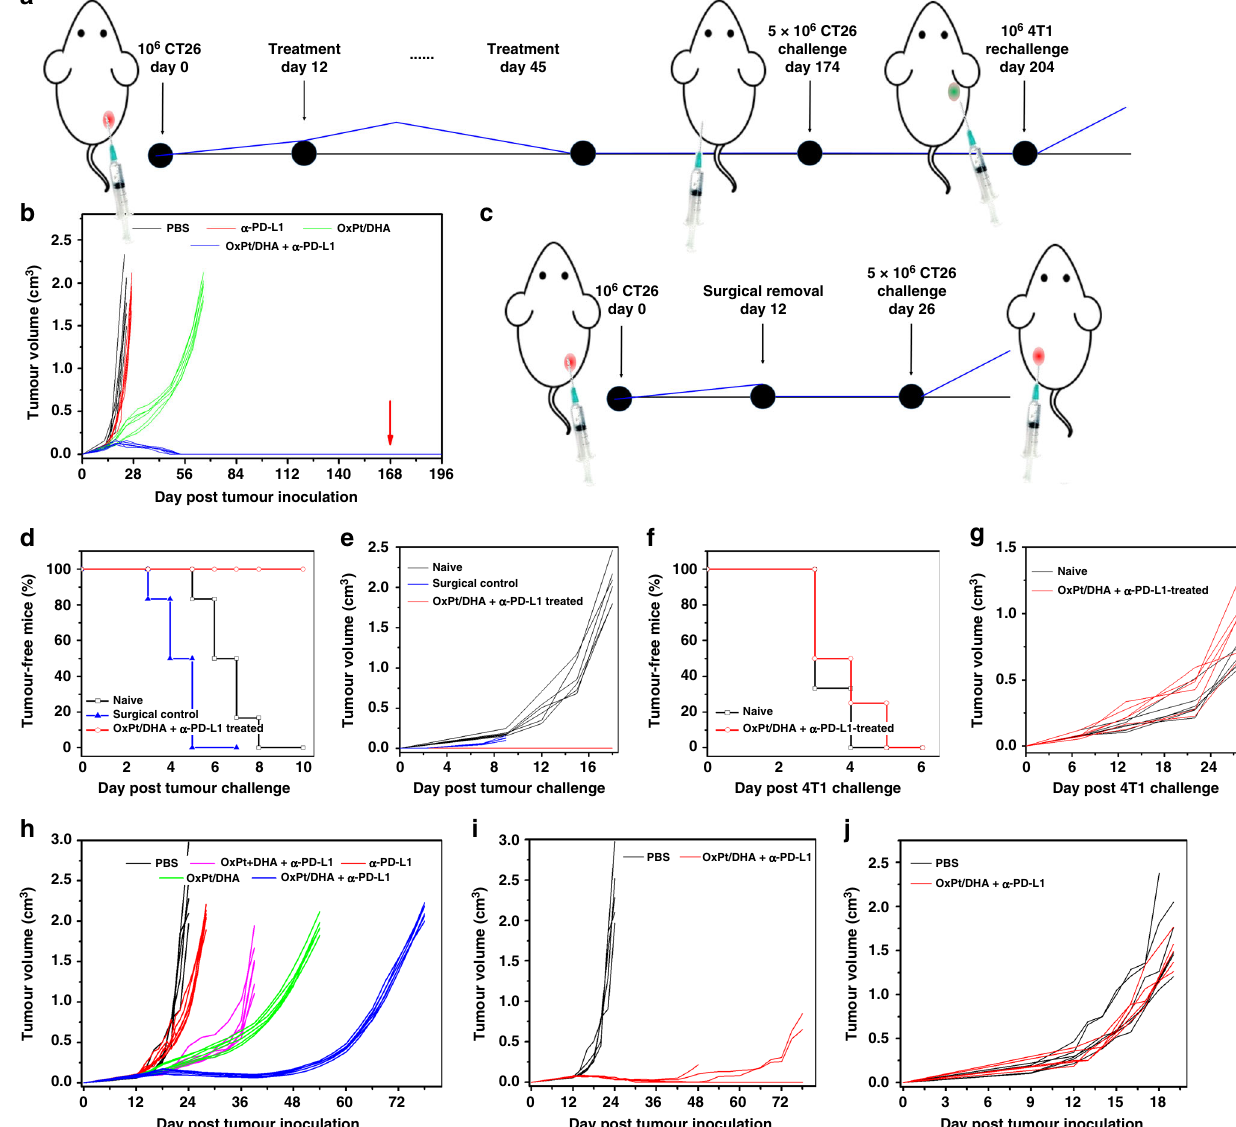
Fig. 6 Enhanced anti-PD-L1 immunotherapy on colorectal cancers. a Experimental design for the treatment and challenge of CT26 tumour-bearing mice. Tumours were allowed to grow for 12 days before treatment to form more immunosuppressive tumours. Then, tumour-bearing mice were intraperitoneally injected with OxPt/DHA combined with α -PD-L1 every 3 days for 12 total doses. Three months after all tumours had disappeared, mice were challenged with CT26 cells, followed by rechallenge with 4T1 1 month later. b Growth curves of CT26 tumours after treatment with OxPt/DHA combined with α -PD-L1 and challenge with CT26 cells (red arrow). c Experimental design for surgery control of CT26 tumour-bearing mice. Percentage tumour-free mice ( d , f ) and tumour growth curve ( e , g ) after challenge with CT26 cells ( d , e ) or rechallenge with unrelated 4T1 tumour cells ( f , g ) in naïve mice or OxPt/ DHA and α -PD-L1-treated mice. h Growth curves of MC38 tumour on C57BL/6 after treatment with OxPt/DHA (8 mg/kg OxPt) combined with α -PD-L1. i , j Therapeutic effect of OxPt/DHA plus α -PD-L1 on C57BL/6 ( i ) at the dose of 16 mg/kg OxPt and Rag2 − / − mice ( j ) at the dose of 8 mg/kg OxPt. Data are each pooled from two independent experiments and expressed as means ± SD ( n = 6 except for ( j ); n = 5 for ( j )). OxPt oxaliplatin, DHA OxPt/kg (Supplementary Figure 26), we chose a dose of 8 mg This was in line with the Norton − Simon hypothesis that more OxPt/kg, 2.8 mg DHA/kg, and/or 75 μ g α -PD-L1/mouse. This frequent doses will lead to greater clinical bene fi t by minimizing dose was at least ten times lower than the maximum tolerated the opportunities for cancer regrowth between doses 29 . Impor- dose (MTD) and allowed for frequent low-dose metronomic tantly, OxPt/DHA increased the effective doses of OxPt and DHA dosing as opposed to conventional infrequent doses at or near the by ~15 and 1000 times, respectively (Table 1). Nearly all of the MTD 28 . Mice were i.p. injected once every 3 days for up to 12 free drugs were cleared out of or decomposed in the bloodstream total doses (Fig. 6a). With signi fi cant OxPt accumulation in within 1 h of intravenous injection (Supplementary Figure 28, tumours 72 h post administration (Supplementary Figure 27), this 29). Despite this, free OxPt leads to signi fi cant peripheral dosing schedule allowed for a dose-dense chemotherapy schedule neuropathy while OxPt/DHA showed no such toxicity (Supple- with a near continuous presence of chemotherapy in the tumour. mentary Figure 30).